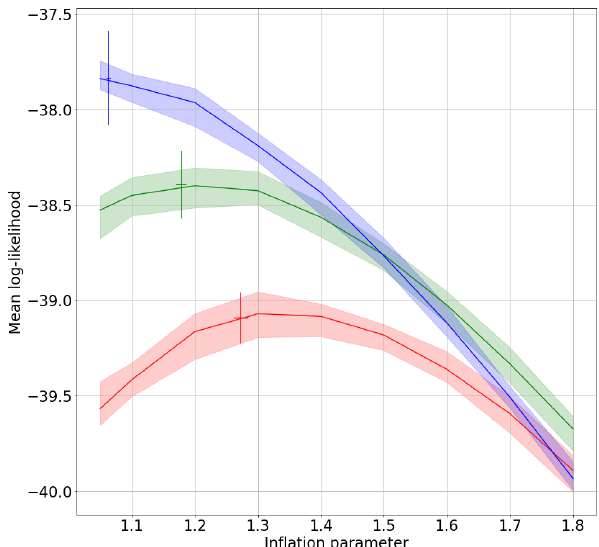
Figure 6. Mean log likelihood for grid points located over northern South America as a function of the inflation coefficient. The shade shows the range between the maximum and minimum values over 10 repetitions of the experiment. The vertical error bars represents the range between the maximum and minimum values of the mean log-likelihood for the experiments with adaptive multiplicative in- flation over 10 repetitions of the experiment. The horizontal error bars indicate the range between the maximum and minimum values of the estimated inflation over 10 repetitions of the experiment. Re- sults are shown for the TRUE (blue line), RH08 (green line), and RH07 (red line) model